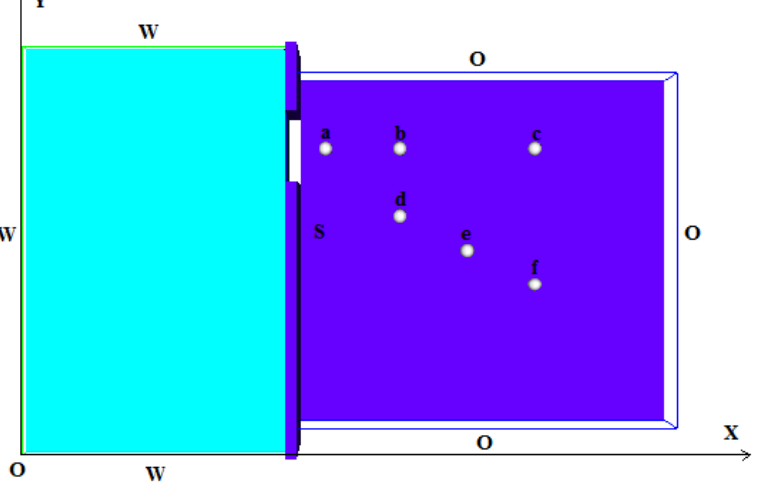
Figure 1. Configuration of experimental model. Table 1. The simulation